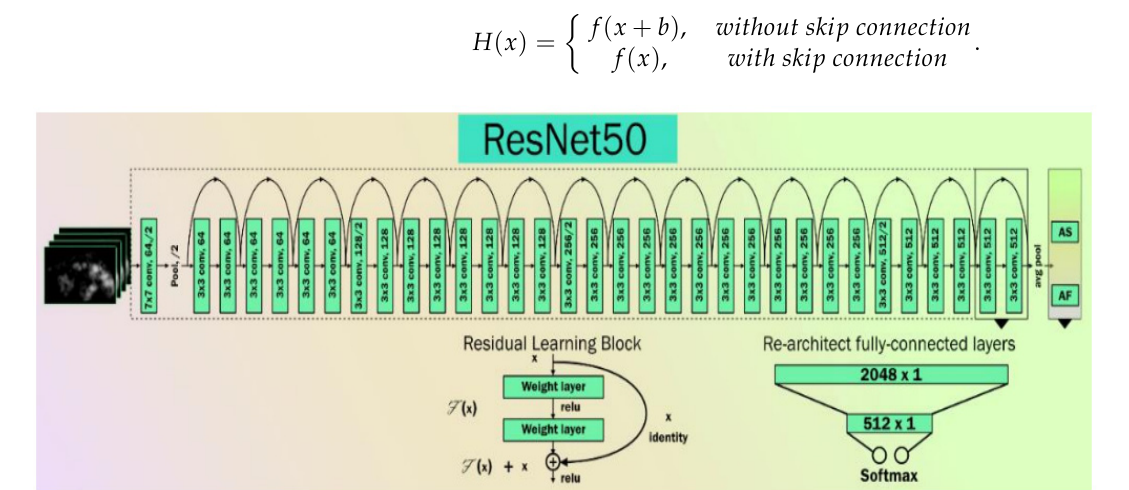
Figure 5. The basic architecture of ResNet.